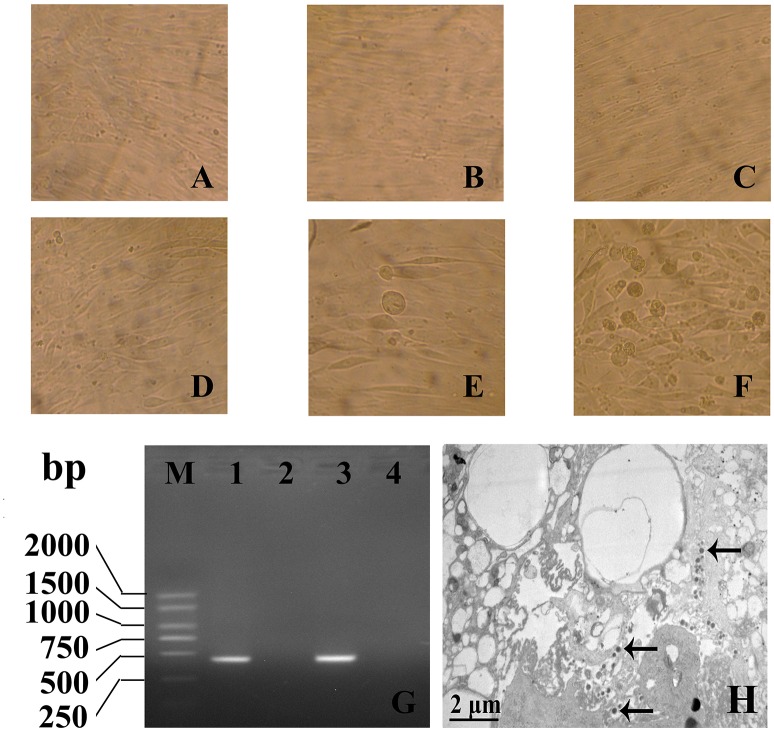
The infection of HCMV to VSMCs was assayed by direct inverted microscope (A–F), RT-PCR (G) and electron microscopic observation (H). (A–C) 1, 4, 8 days of mock infection group; (D–F) 1, 4, 8 days of HCMV infection group (× 400); (B) HCMV IE gene could be amplificated from VSMCs infected with HCMV. M: DL2000 plus DNA marker; 1: IE gene PCR products; 2: Mock infection 3: Positive control; 4: Negative control; (C) On the third day after infection, the viral particles were visible within the cell (Arrow, × 10,000).